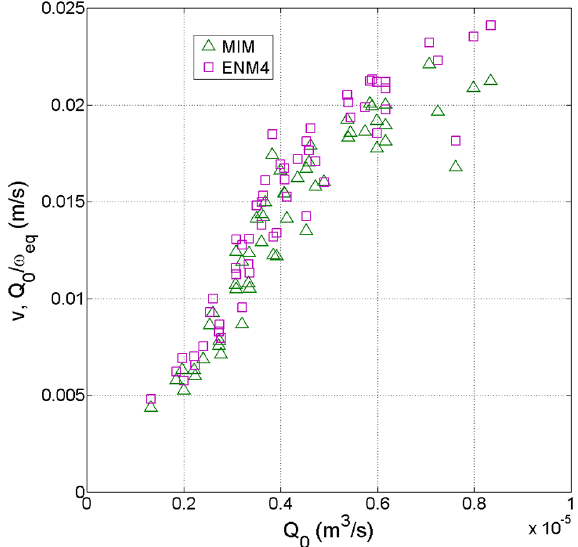
Figure 14. Dispersion D (m 2 s − 1 ) as function of velocity for MIM and ENM4. Note that for MIM, D is determined assum- ing the length of the medium equal to the length of the main path ( l = 0 . 601m). Instead for ENM4 D is determined as D = Q 0 · α L /ω eq